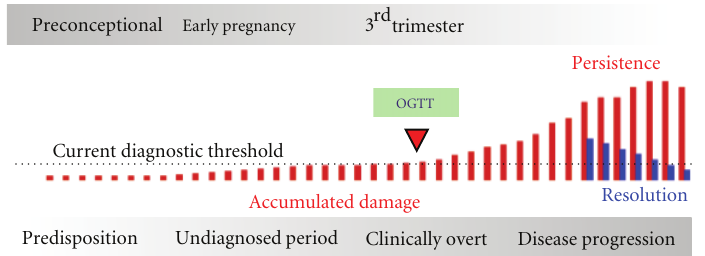
Figure 2: GDM disease progression. GDM is currently diagnosed (Clinically Overt) in 3rd trimester (24–28 weeks of gestation) following an oral glucose tolerance test (OGTT). Using this diagnostic threshold, there is no opportunity to prevent pathological changes (accumulated damage) that may occur during 1st and 2nd trimester (Undiagnosed Period). The implementation of screening tests during early pregnancy or the preconception period a ff ords opportunity to identify women at risk of disease and to evaluate intervention strategies on pregnancy outcome and the long-term health of both mother and